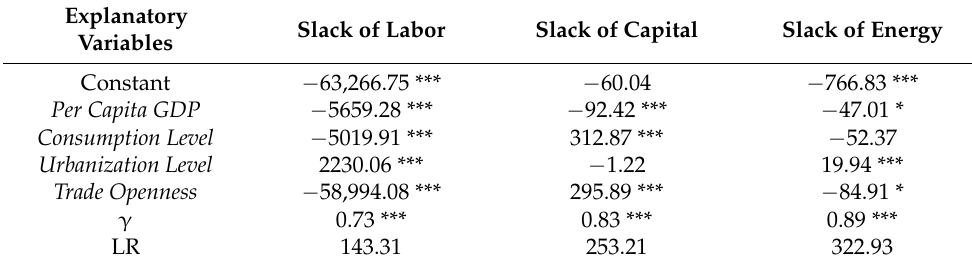
Figure 2. Regional comprehensive eco-efficiency of China’s tourism industry (2008–2017). Table 5. The results of the SFA